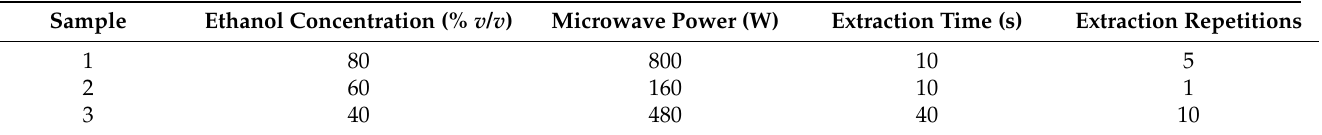
Table 1. Extraction conditions of microwave-assisted extraction for parsley, lovage, rosemary, and